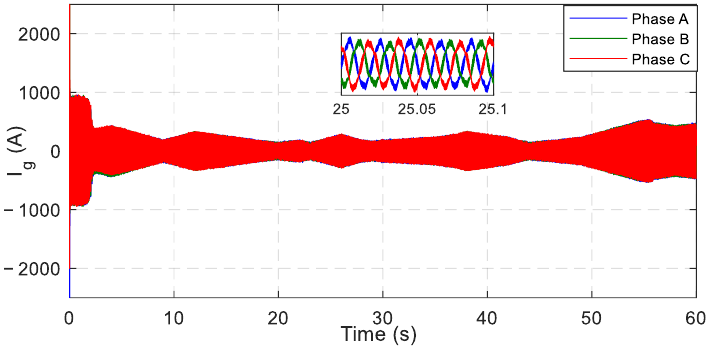
Figure 15. Grid currents of WECS with PI controller.